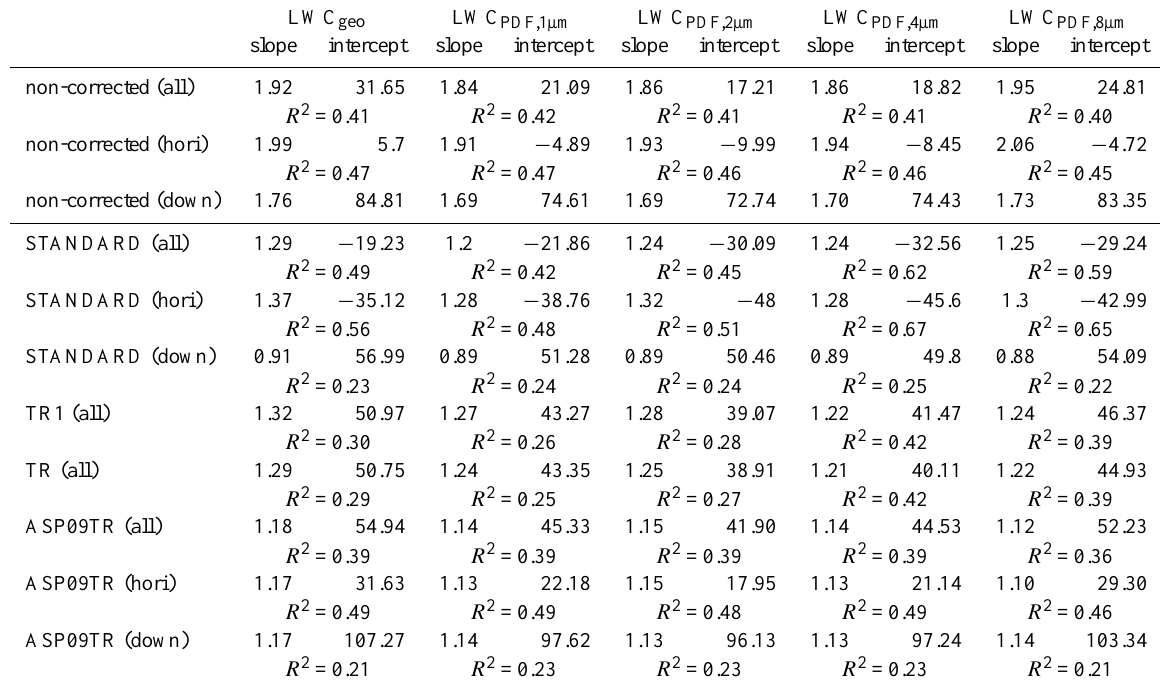
Table 4. Slope, intercept and R 2 for geometric mean regressions between LWC PVM and LWC geo as well as LWC PDF ,a µ m for non-corrected data as well as for the different correction categories presented in Table 3. Brackets indicate whether all cloud data from CLACE 2010 (all) or only data during horizontal sampling (hori) or downward sampling (down) were